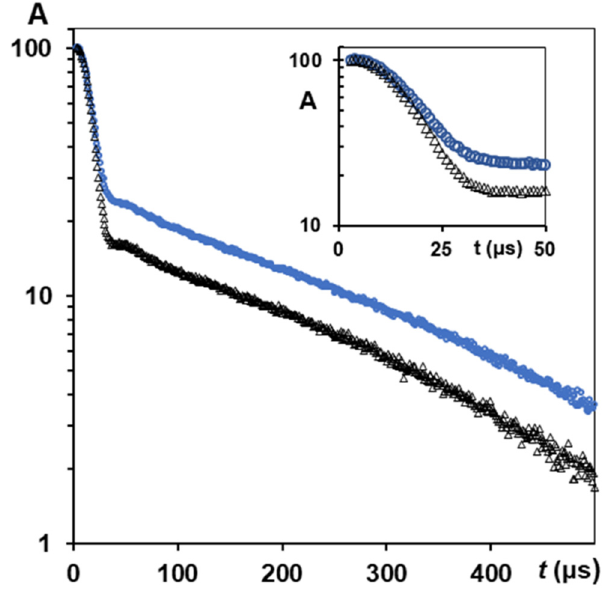
Table 5. This presents the T 2 data (0° and 90° orientations, HL = 0.084) for silks B.mori (untreated) and for silk fibres measured after the application of mechanical loading. In silk fibres oriented at 90° to static magnetic field B 0 , the value T 2e90 = 267 µs (after tensile loading) exceeded T 2e90 = 212.5 µs (untreated silk fibres) by 1.25 times, whereas, for 0° ori- entation, the increase in T 2e0 (effect of mechanical loading to silk fibres B.mori ) was 222/157.4 = 1.44.